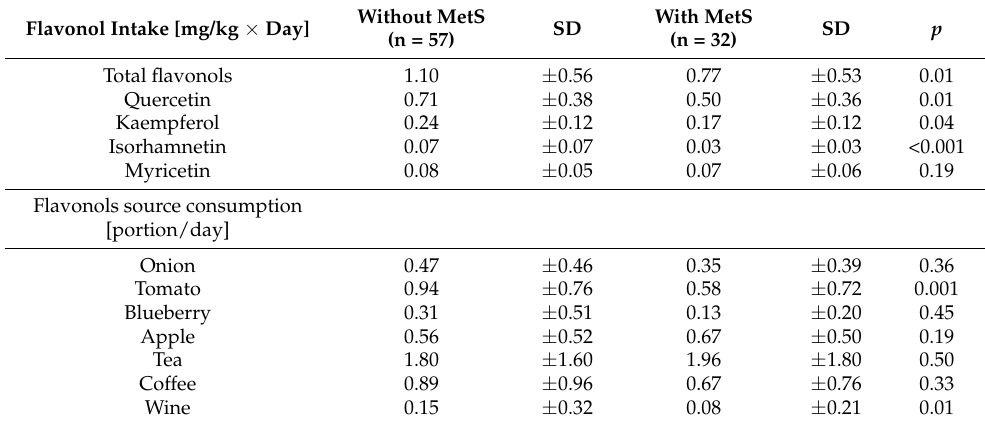
Table 1. The comparison of mean daily flavonols intake and flavonol source consumption between the patients with and without metabolic